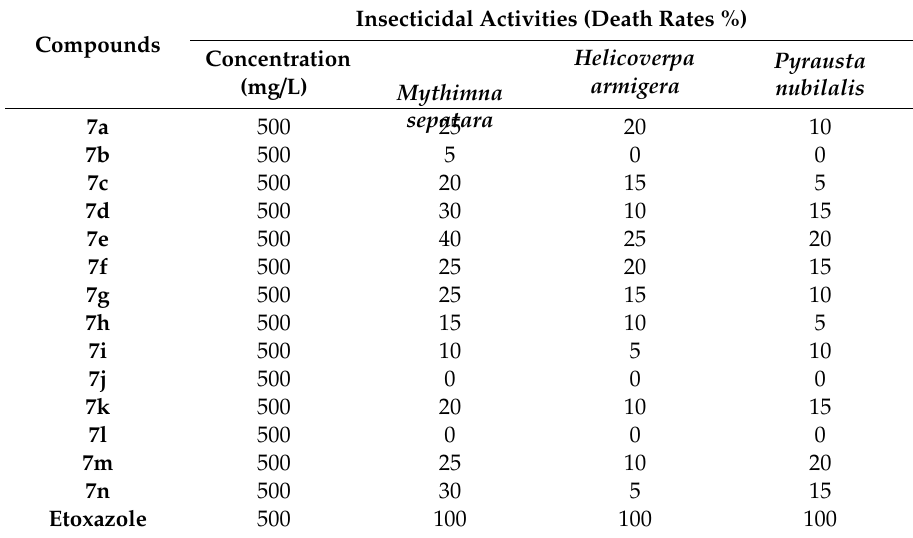
Table 2. Insecticidal activities of title compounds 7a – 7n .